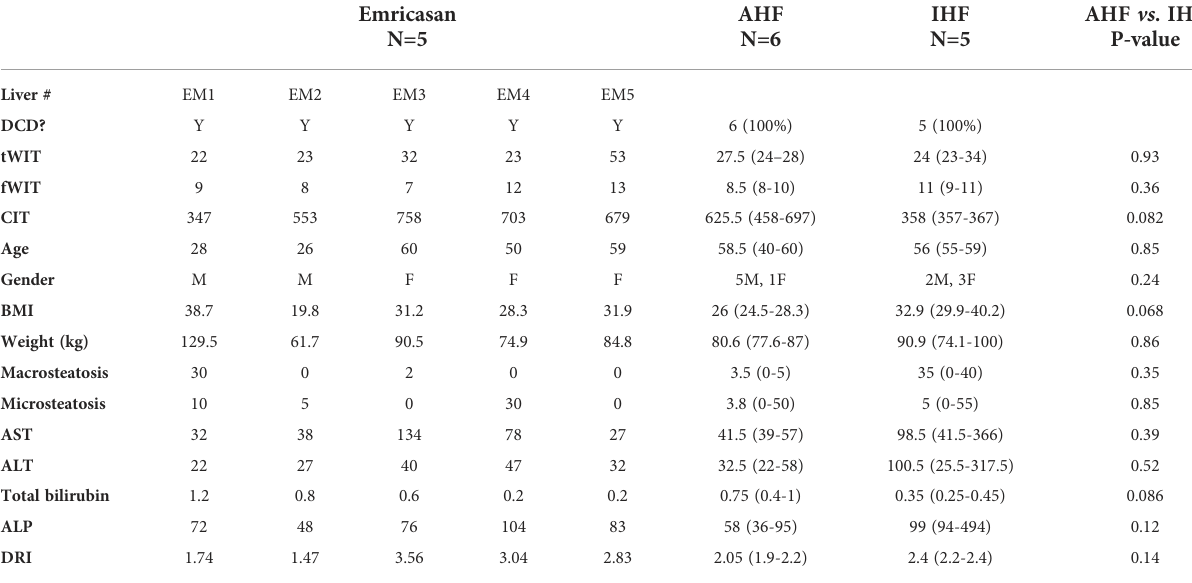
TABLE 1 Discarded liver donor